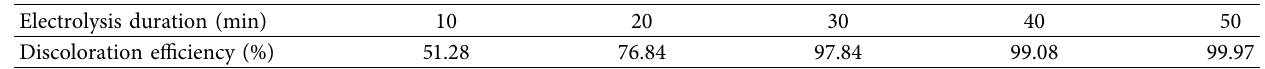
Table 1: Effect of electrolysis time on MB discoloration